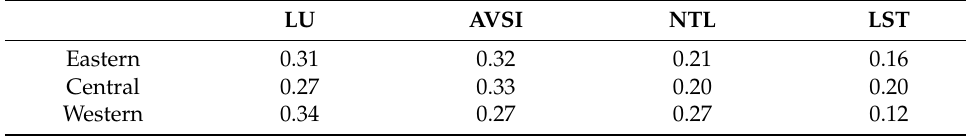
Table 4. Ranking of the importance of influencing